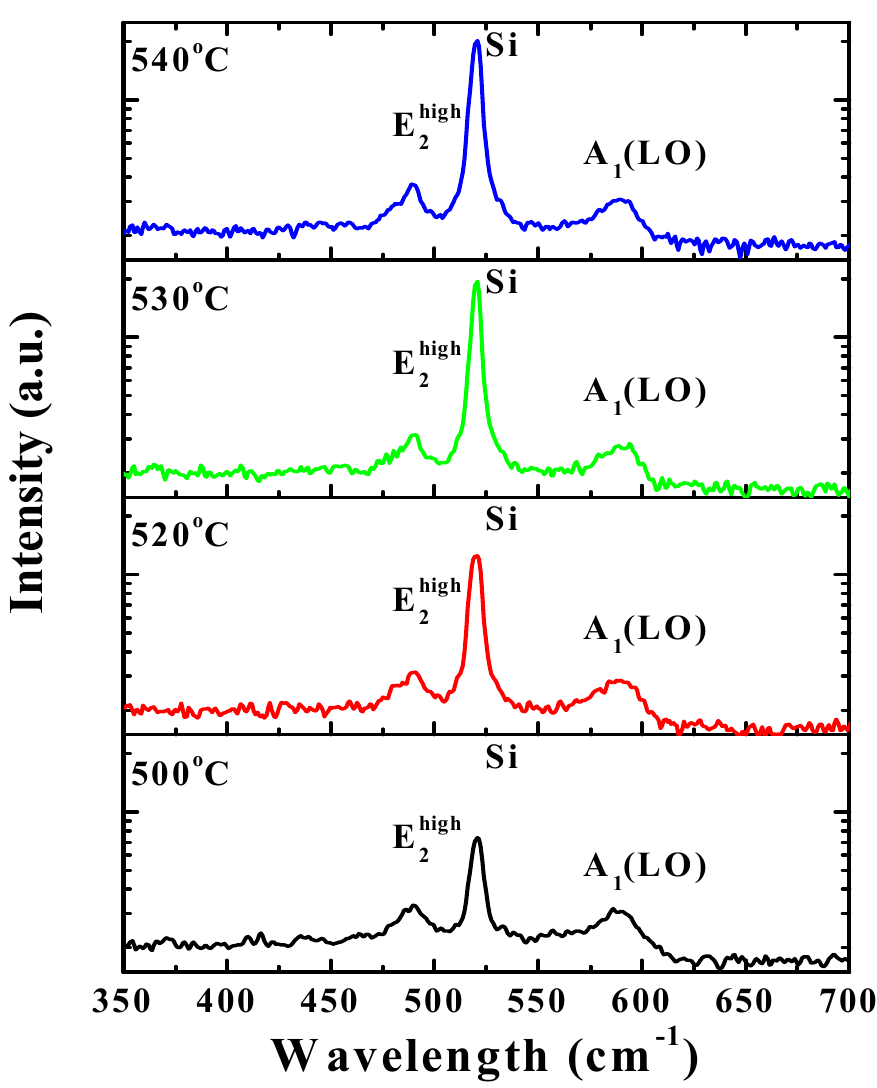
Figure 5. Room temperature Raman spectra of InN nanocolumns on a nitrided Si(111) substrate.